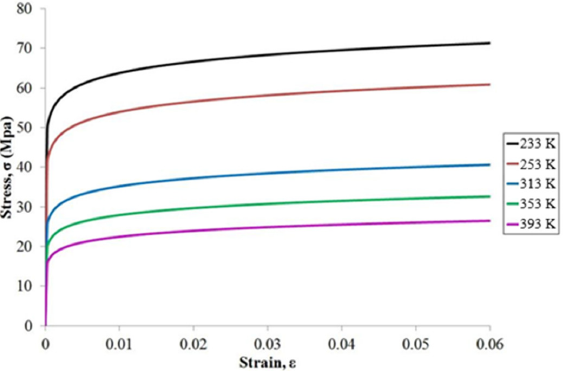
Figure 5. The stress–strain curve for SAC305 [19,21].